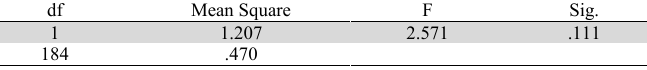
Result of testing of differences of gender on teacher’s behavioral intention of using information technology in lectures Test of Homogeneity of Variances Sum of Squares